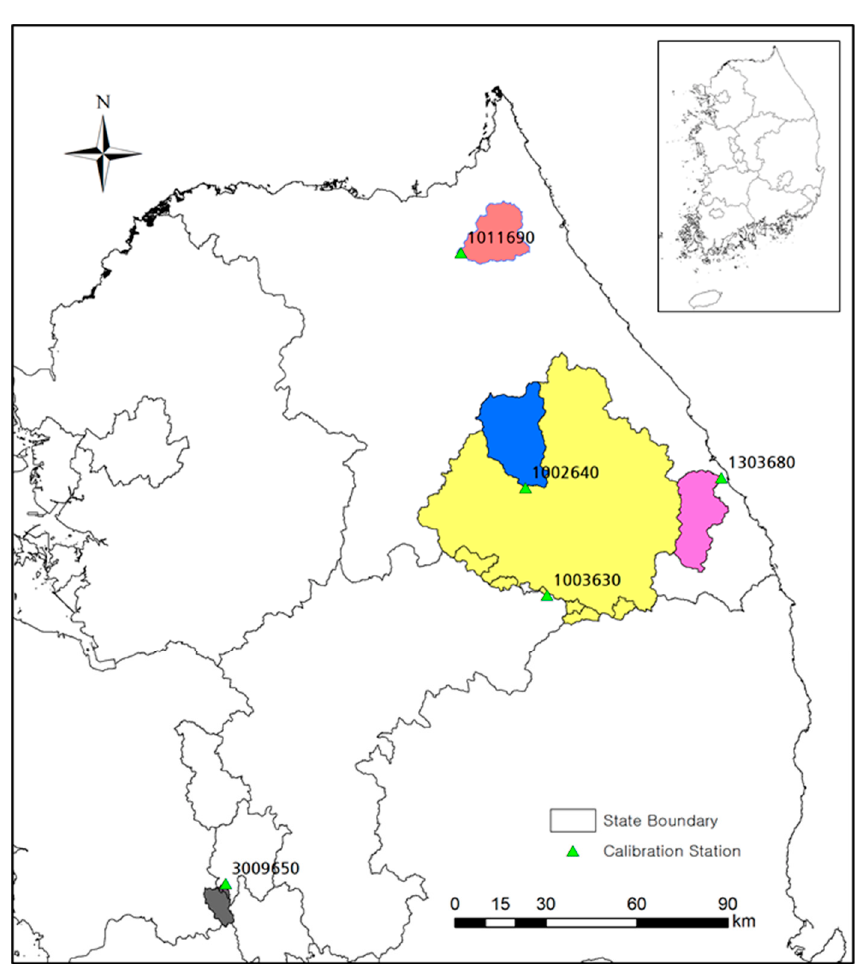
Figure 2. Map of South Korea at the top panel and zoomed area showing the location of the selected five stations for model calibration and their upstream catchments. Table 1. Five calibration stations used in this study with their key geographical characteristics (catchment size, average slop, and maximum of standard deviation (SD) of altitude), annual total rainfall and years used for calibration and verification.